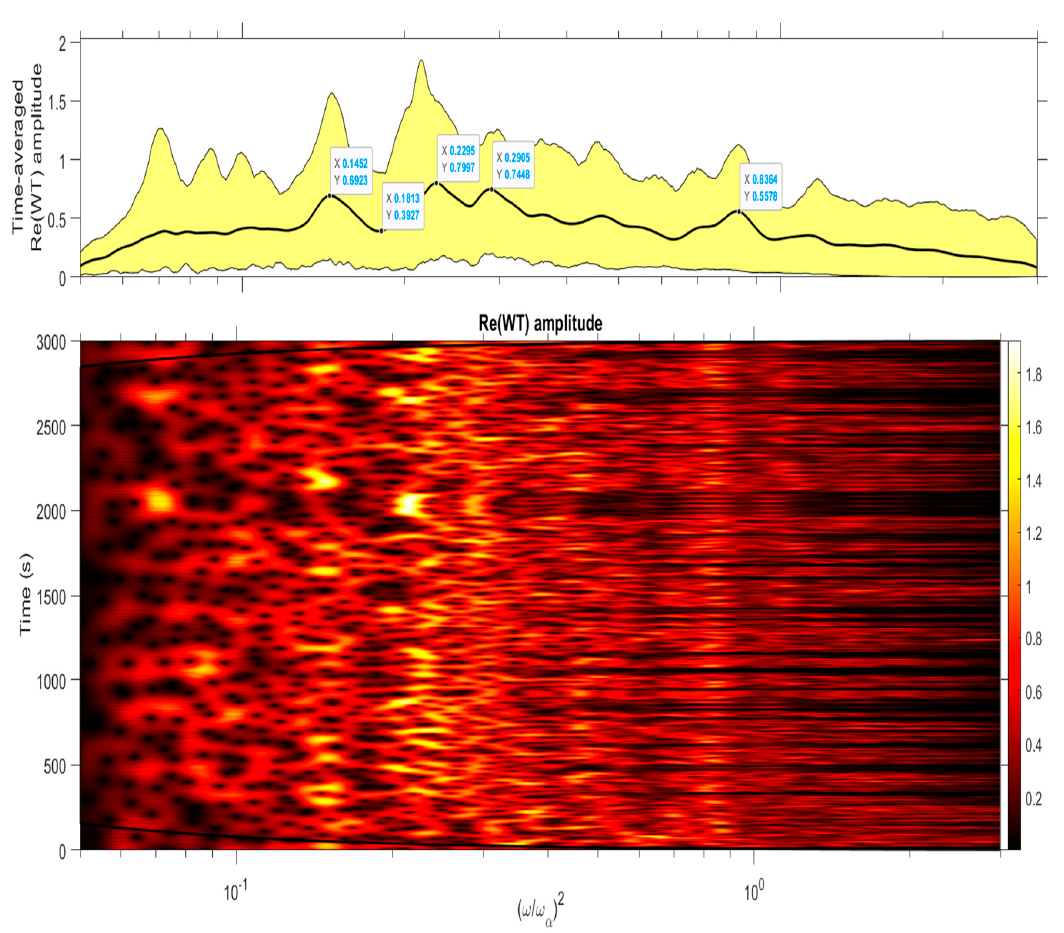
Figure 19. Wavelet time–frequency analysis: Control perturbation signal ( Q o = 5).